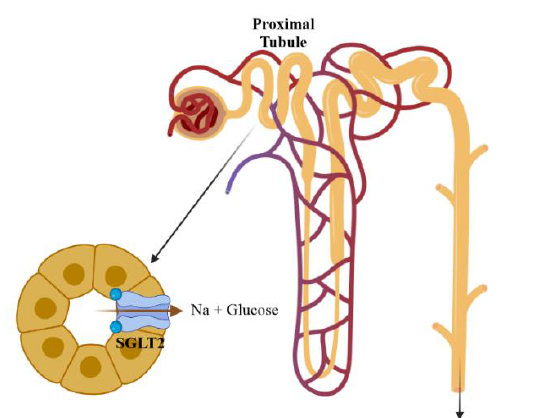
Figure 1: Schematic picture of SGLT2 activity. SGLT2 inhibitors inhibit this process and induce glucose and sodium excretion in